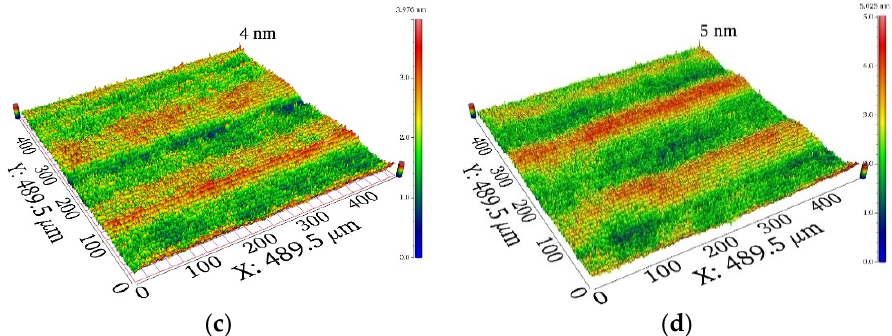
Figure 1. Three-dimension surface morphologies on the area of 490 × 490 μ m 2 by optical profiler for the ( a ) A-plane, ( b ) C-plane, ( c ) R-plane and ( d ) M-plane.